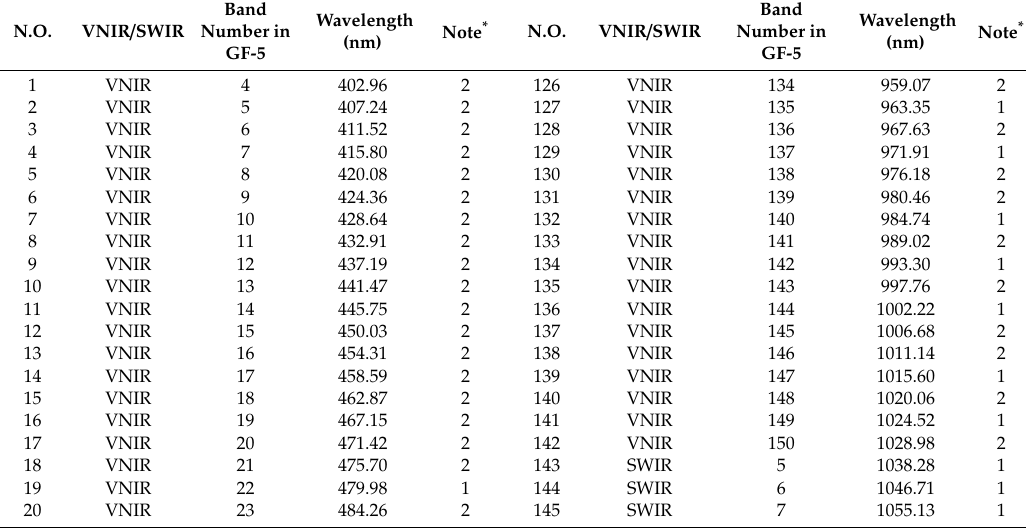
Table A1. The number and wavelength of valid bands in GF-5 hyperspectral data (* the value of 1, 2, 3 in the field of ‘Note’ indicates the bands selected as simulated Hyperion, extra bands in VNIR and extra bands in